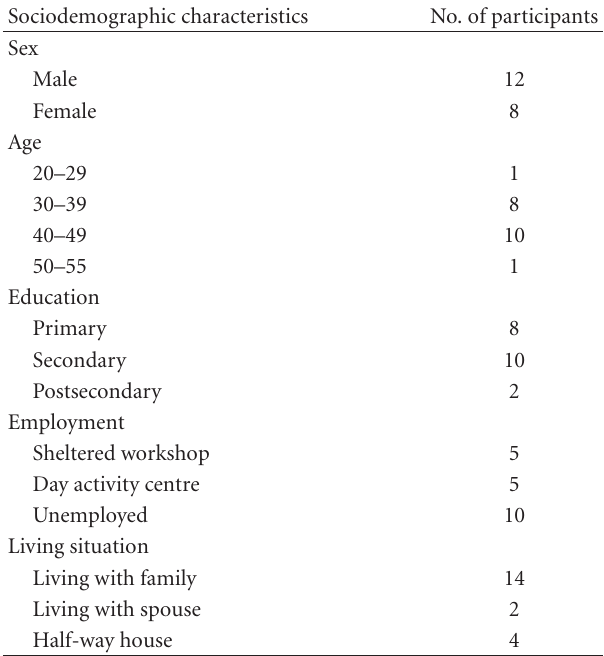
Table 1: Profile of research participants. Sociodemographic